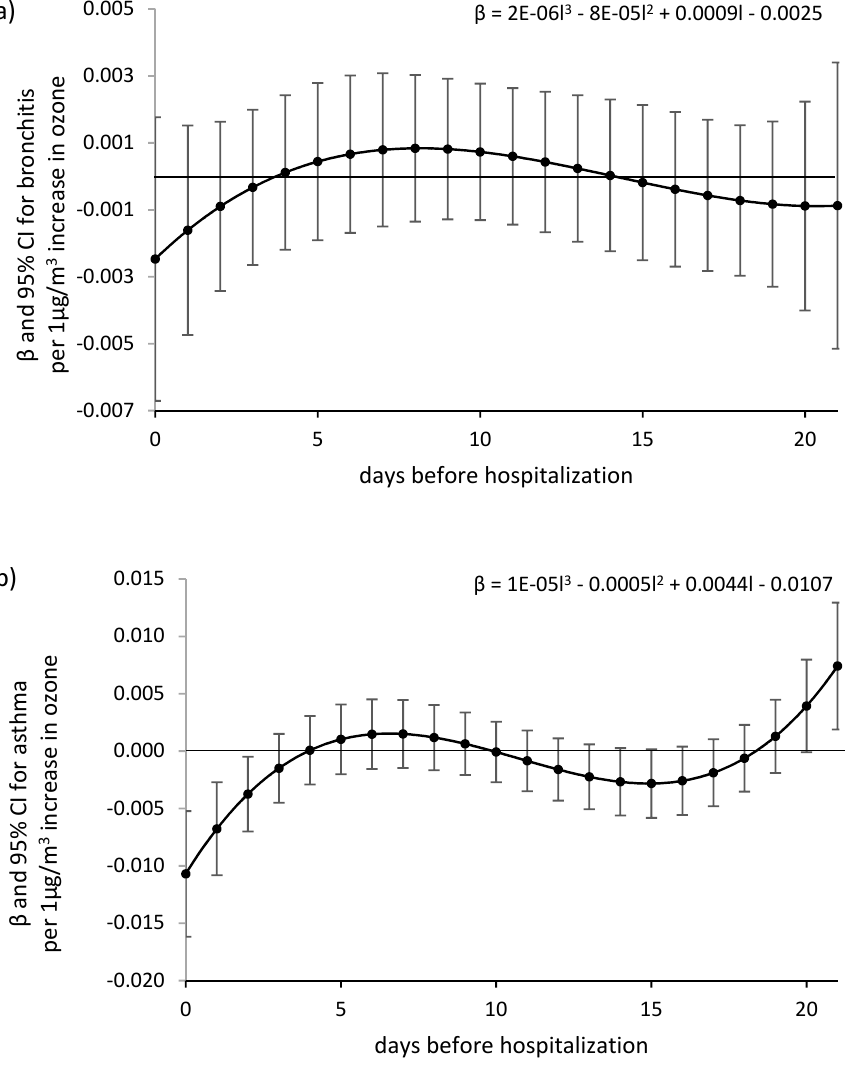
Figure 2. β l coe ffi cients for the Almon model with the approximation with 3rd-degree polynomial Figure 2. 𝛽 (cid:3039) coefficients for the Almon model with the approximation with 3rd-degree polynomial function, for the number of: Bronchitis ( a ) J20–J21, and asthma ( b ) J45–J46 hospitalization related to function, for the number of: Bronchitis (a) J20–J21, and asthma (b) J45–J46 hospitalization related to increase of 8-h ozone concentration by 1 µ g / m 3 . The day 0—the day of registered hospitalization; the increase of 8-hour ozone concentration by 1 µ g/m 3 . The day 0—the day of registered hospitalization; day l —the day before the day l —the day before hospitalization.